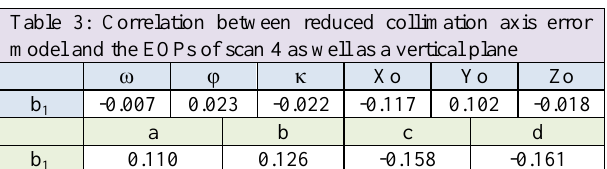
Table 3: Correlation between reduced collimation axis error model and the EOPs of scan 4 as well as a vertical plane